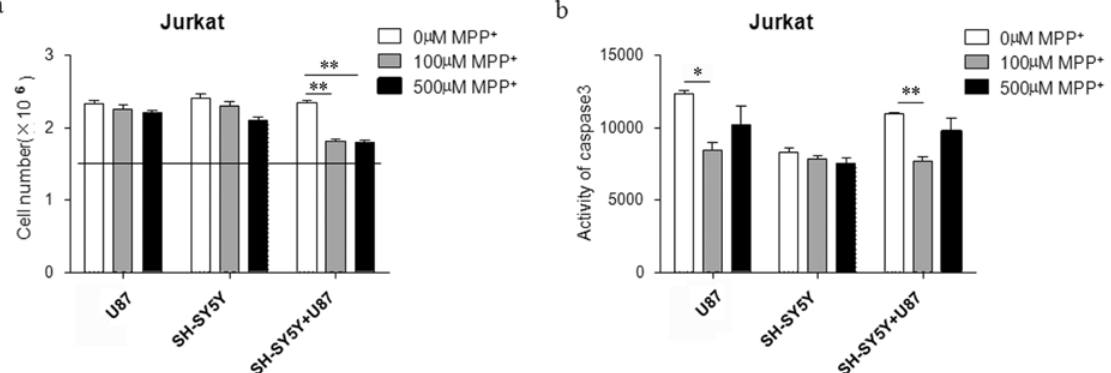
Figure 2. MPP + -treated co-culture medium of SH-SY5Y and U87 cells can inhibit proliferation of Jurkat cells dissociated with apotosis. ( a ) The cell number of Jurkat was decreased in MPP + -treated co-culture medium compared to control without MPP + (straight line means seeding cell number). The medium derived from the incubation of SH-SY5Y or U87 cells with (or without) the presence of MPP + as background control; ** p < 0.01 compared with Jurkat in co-culture medium without MPP + ; ( b ) Caspase3 activity of Jurkat cells in MPP + -treated co-culture medium was lower than control without MPP + . The medium derived from the incubation of SH-SY5Y or U87 cells with (or without) the presence of MPP + as background control. * p < 0.05 compared with Jurkat in U87 incubation medium without MPP + ; ** p < 0.01 compared with Jurkat in co-culture medium without MPP +